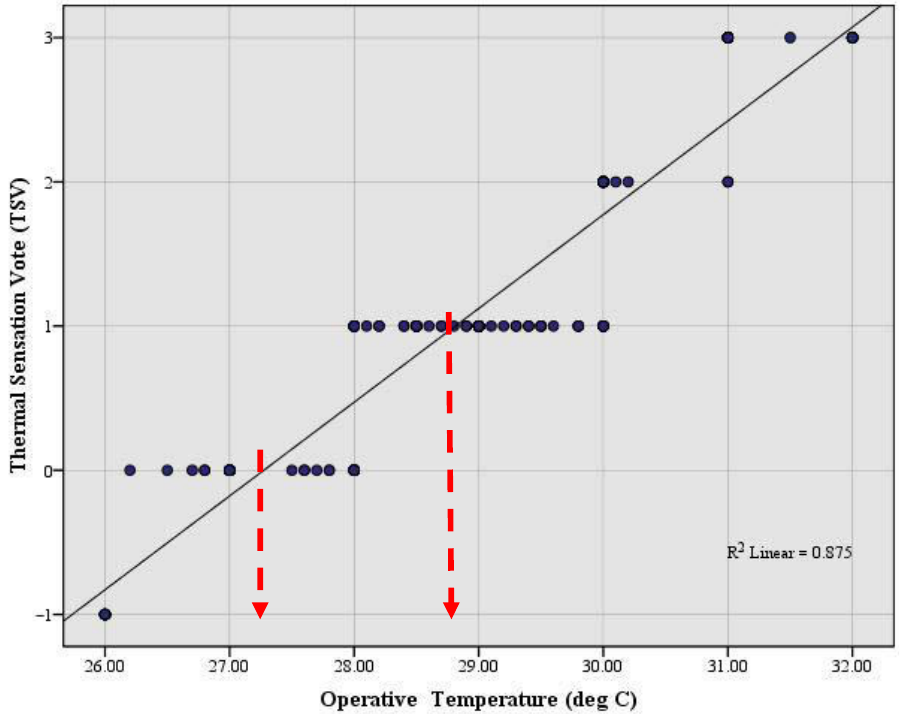
Figure 5. Linear regression of thermal sensation votes (TSV) versus operative temperature (OP).